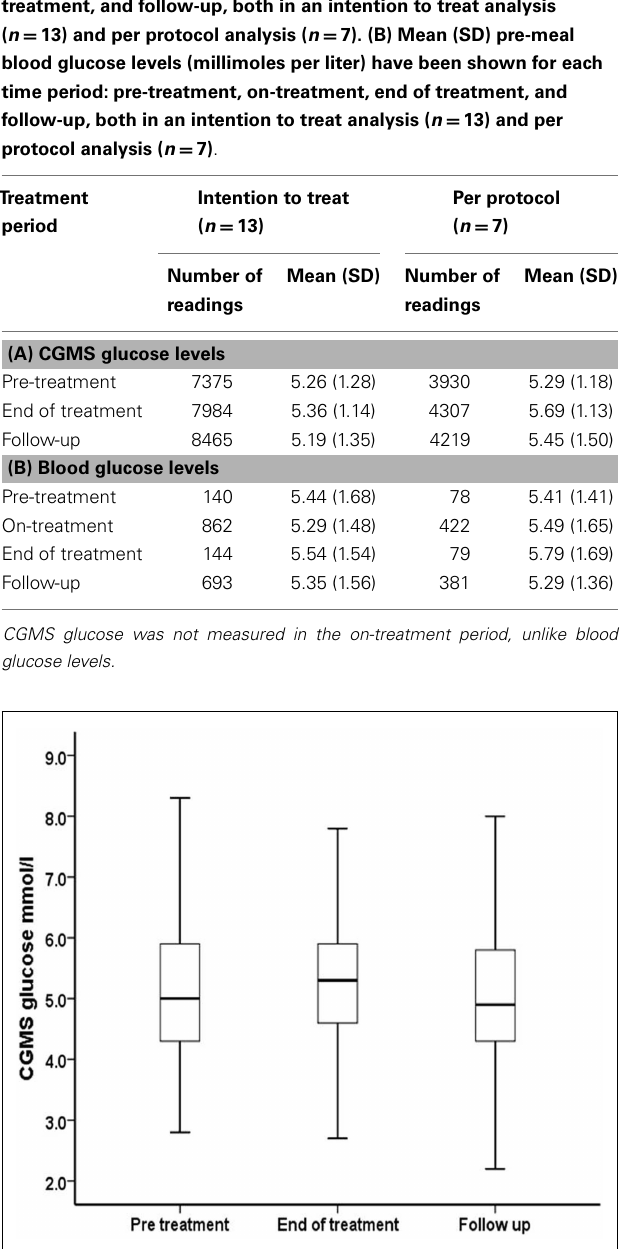
FIGURE 2 | Median, interquartile range, and ± 2 SD values for CGMS glucose (millimoles per liter) have been summarized for all patients receiving PUFA supplements in intention to treat analysis